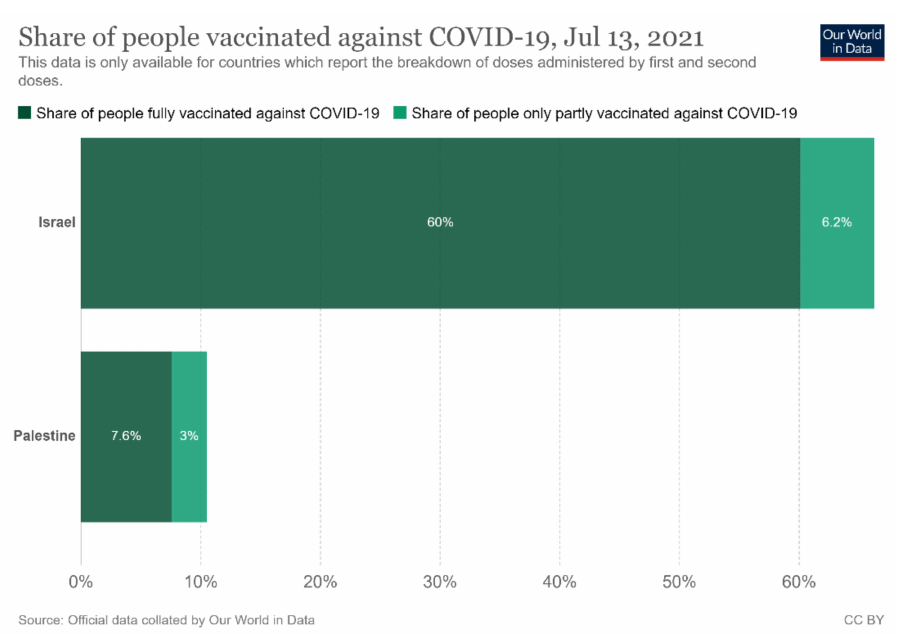
Figure 1. Share of People Vaccinated Against COVID 19, 13 July 2021 for Israel and Palestine [8], used under Creative Commons License CC BY